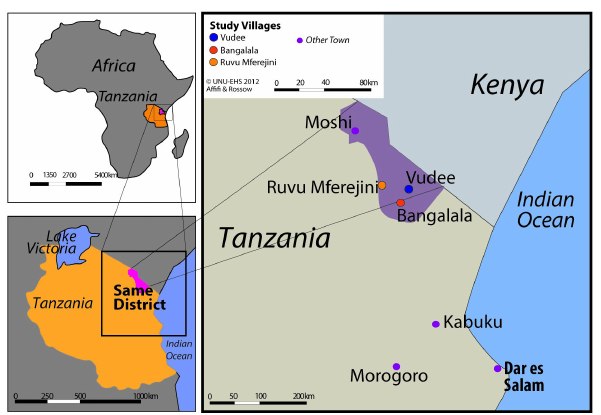
Figure 2. Location of the Rainfalls Tanzania research site. Source: Afifi et al. (2014; their map